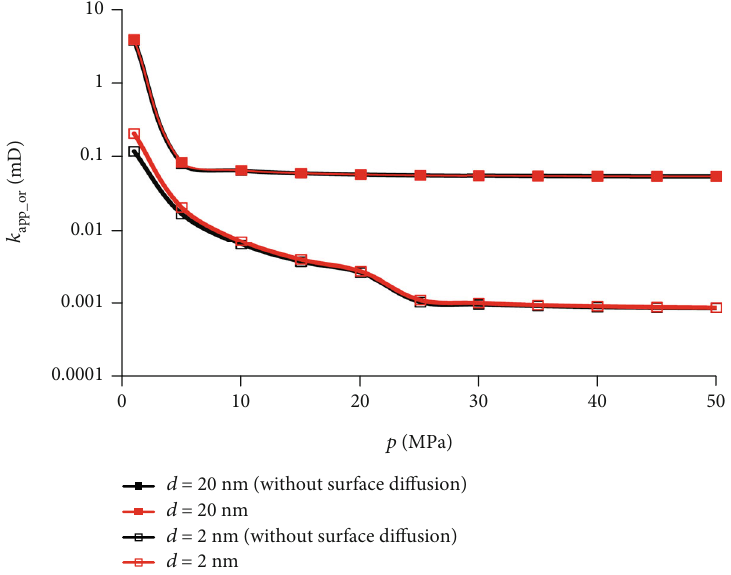
Figure 9: Organic pore AGP curves in with and without considering the surface di ff usion e ff